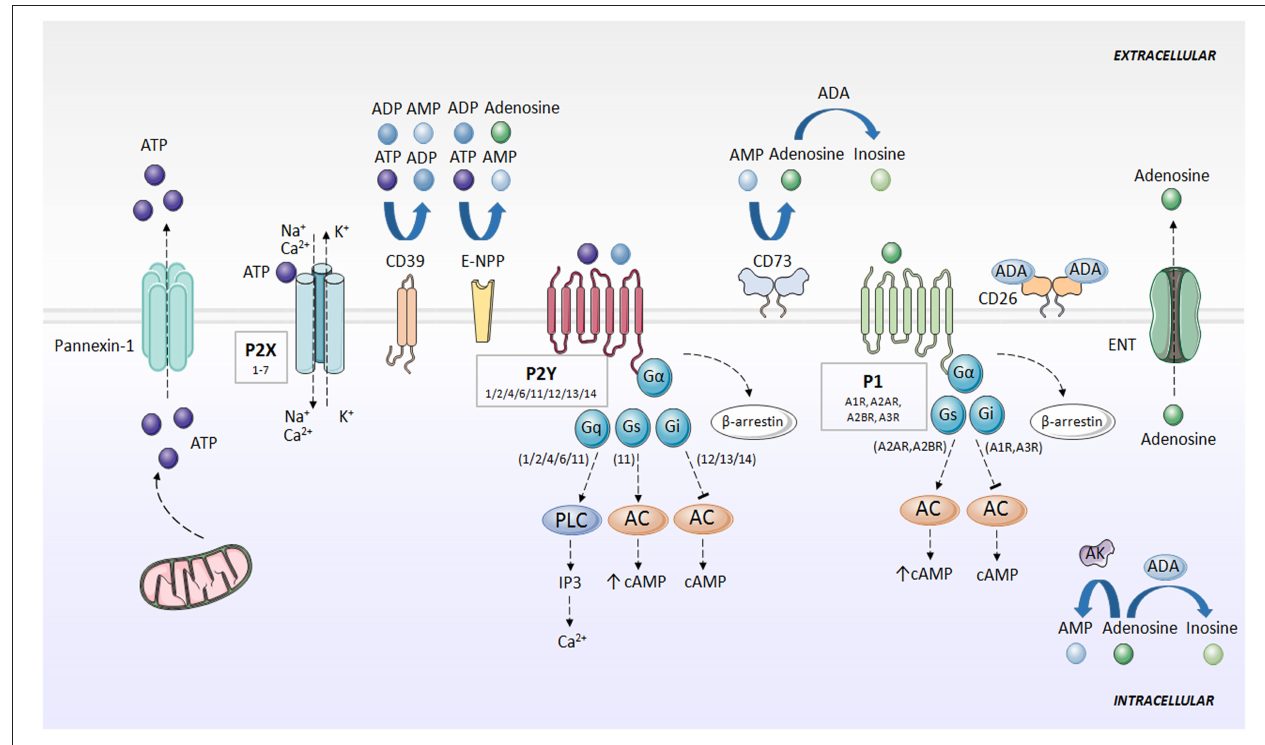
FIGURE 1 | Purinergic signaling and specific receptors for extracellular nucleotides. ATP is released to the extracellular space mainly through pannexins (e.g., Pannexin-1). Then, ATP is rapidly degraded to ADP, AMP, and adenosine by the action of CD39, E-NPP and CD73. Adenosine can be converted to AMP through AK action, or degraded to inosine by ADA. Adenosine is also directly released outside the cell through ENT. P2X receptors activated by ATP, forming an ion channel for Na + , K + , and Ca 2 + . P2Y receptors are activated by ATP and ADP, and associate with G proteins, promoting intracellular second messengers’ cascades, including Ca 2 + and cAMP. Adenosine activates P1 receptors, coupled to G-proteins. A1R and A3R interaction with Gi, and A2AR and A2BR with Gs. P1 and P2Y receptors desensitized through internalization by β -arrestins. AC, adenylate cyclase; ADA, adenosine deaminase; ADP, adenosine diphosphate; AK, adenosine kinase; AMP, adenosine monophosphate; ATP, adenosine 5 ′ -triphosphate; cAMP, cyclic adenosine monophosphate; CD26, dipeptidyl peptidase IV; CD39, ecto-nucleoside triphosphate diphosphohydrolase; CD73, ecto-5 ′ -nucleotidase; E-NPP, ecto-nucleotide pyrophosphatase/phosphodiesterase; ENT, nucleoside transporter; G, G protein; IP3, inositol trisphosphate; P1, adenosine receptors; P2X, ionotropic nucleotide receptors; P2Y, metabotropic nucleotide receptors; PLC, phospholipase